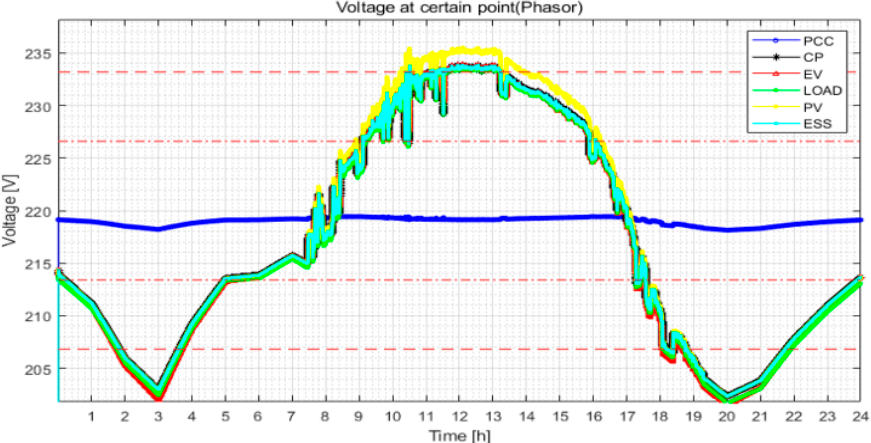
Figure 12. Analysis (voltage) of hosting capacity characteristic at EVC infrastructure without ESS.